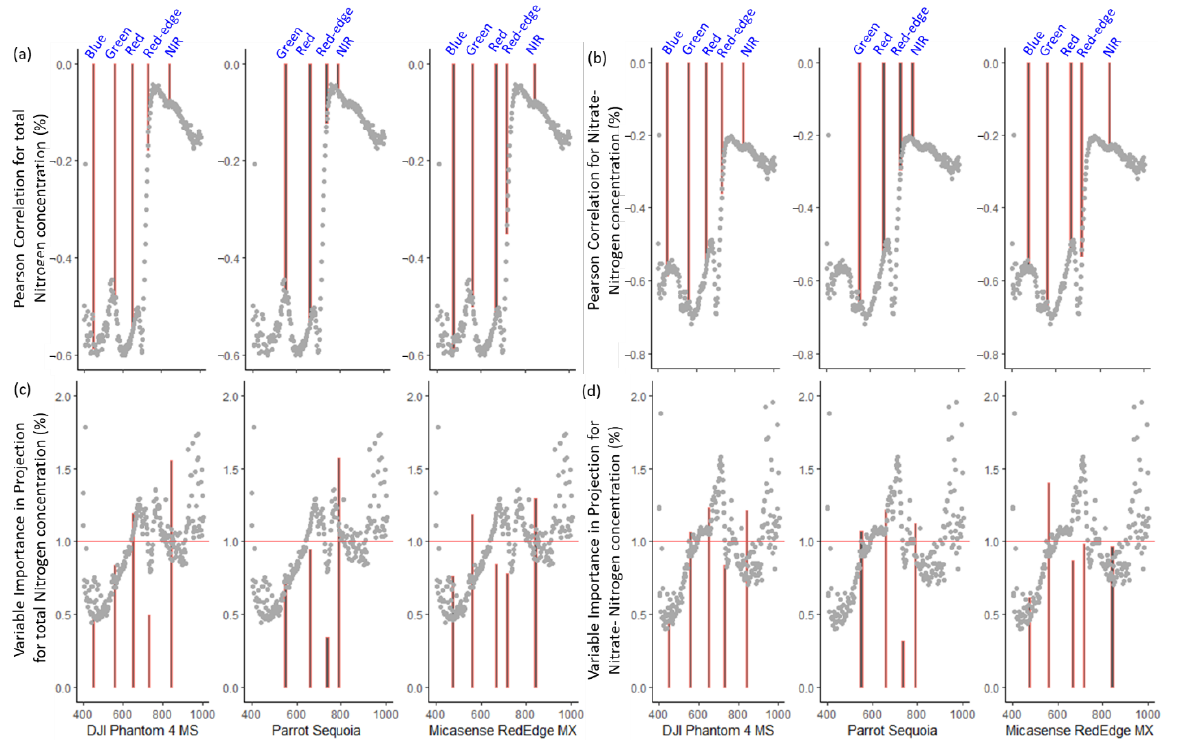
Figure 5. Bar plots of the variable importance of the imagery bands in estimating N concentrations. ( a , b ) Pearson correlations. ( c , d ) Variable Importance in Projections (VIPs). ( a , c ) The total N concentration, and ( b , d ) the petiole nitrate-N concentration. The gray dots represent hyperspectral wavelengths. The red horizontal line in ( c , d ) marks where the VIP score equals 1.